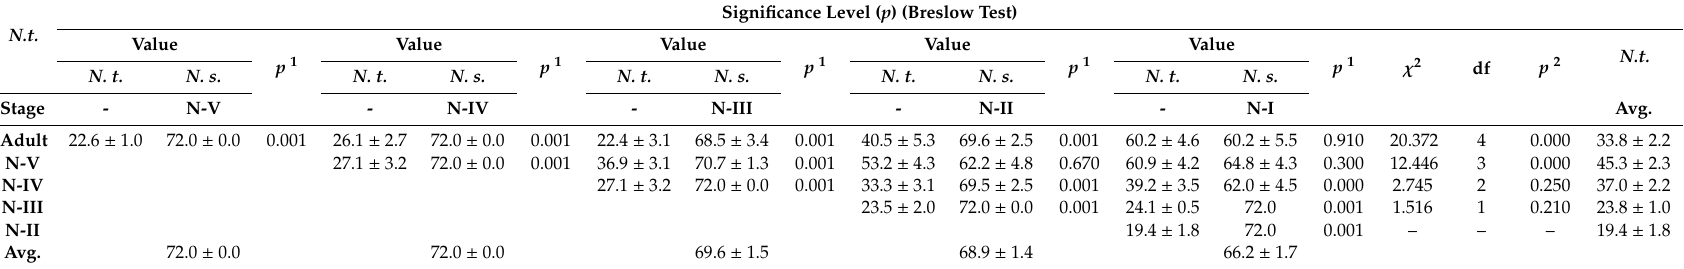
Table A7. Aggressiveness of Nabis pseudoferus predation (intraguild competition) on Nesidiocoris tenuis ( N. pseudoferus was always in a lower stage class than N. tenuis ), measured as survival time (hours) ( ± SE), when caged one individual of each species during 72 h under laboratory conditions (25 ± 1 ◦ C and 60–80% RH) and without